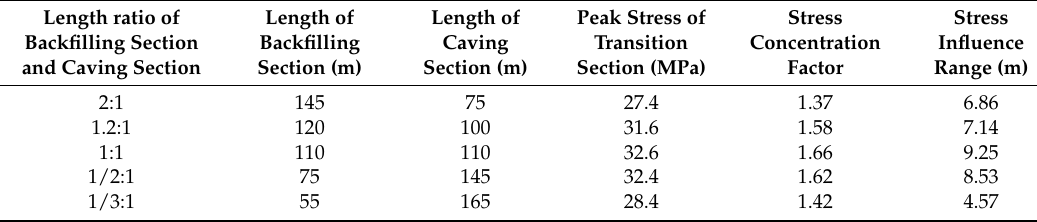
Table 3. Stress distribution at different length ratios of the backfilling section and caving section.